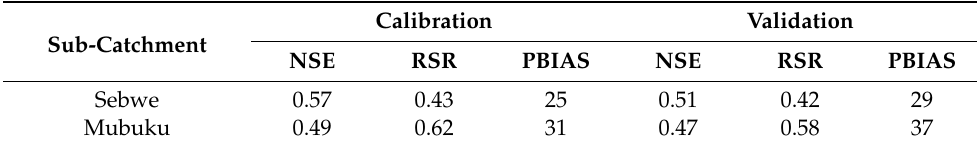
Table 3. NAM model performance during calibration and validation.